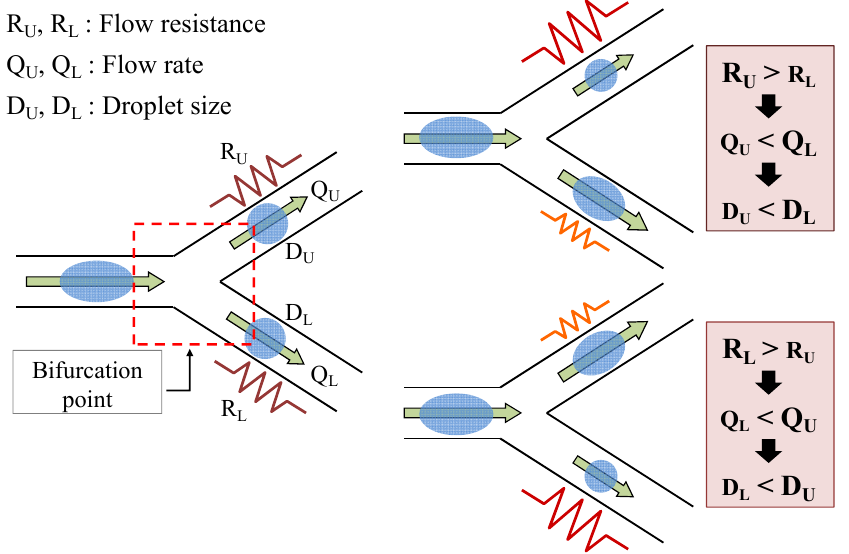
Figure 1. Controllable microdroplet division in bifurcating microchannel using a change in flow resistance of downstream.